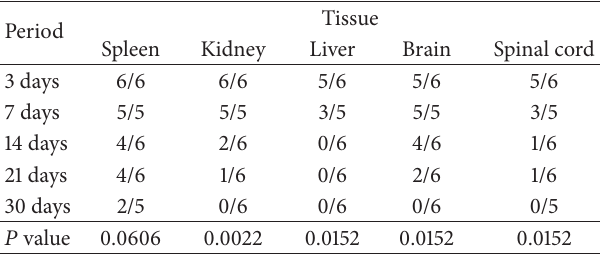
also reached the CNS. As observed in Table 1, the viable Table 1: Frequency of C. albicans -positive tissues.